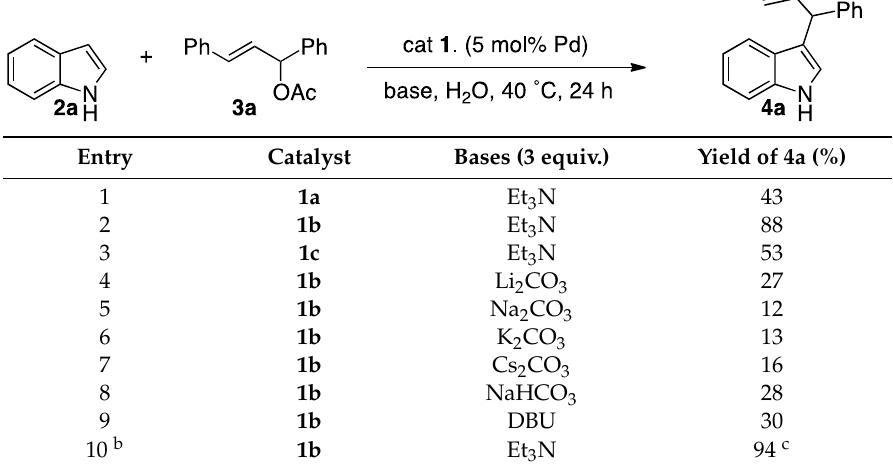
a : All reactions were performed in water at 40 °C for 24 h. The ratio of 3 (mol)/indoles (mol)/base (mol)/Pd (mol)/H 2 O (mL) = 1.5/1/3/0.05/1.5. Yields were determined by gas chromatography (GC) based on n -dodecane as an internal standard. b : This reaction was performed under scaled-up conditions ( 3 (3 mmol)/indoles (2 mmol)/base (6 mmol)/Pd (0.1 mmol)/H 2 O (15 mL). c : One day later,